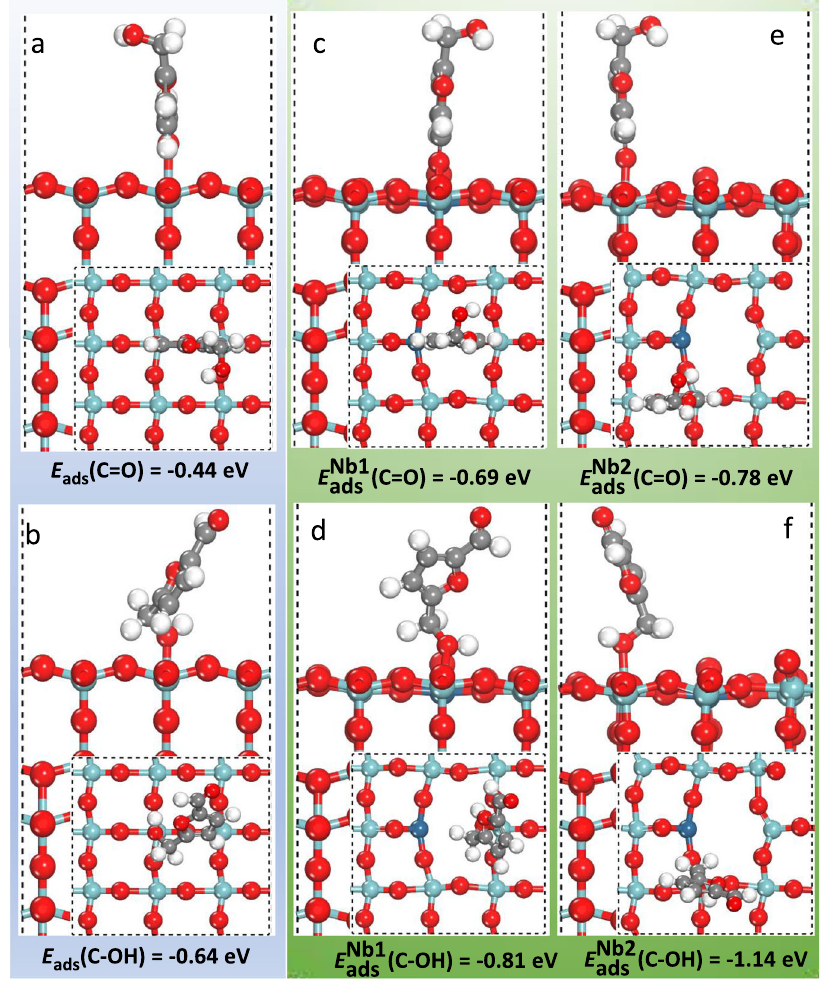
Fig. 5 Calculated adsorption energy and structures of HMF. (side view, Inset: top view). a , b Nb 2 O 5 surface, which marked with blue background. c – f Pt 1 / Nb 2 O 5 -Ov surface, which marked with green background. The adsorption modes for C = O (upper row) and the C – OH (bottom row) in HMF. Silver: C, white: H, red: O, light blue: Nb, blue: